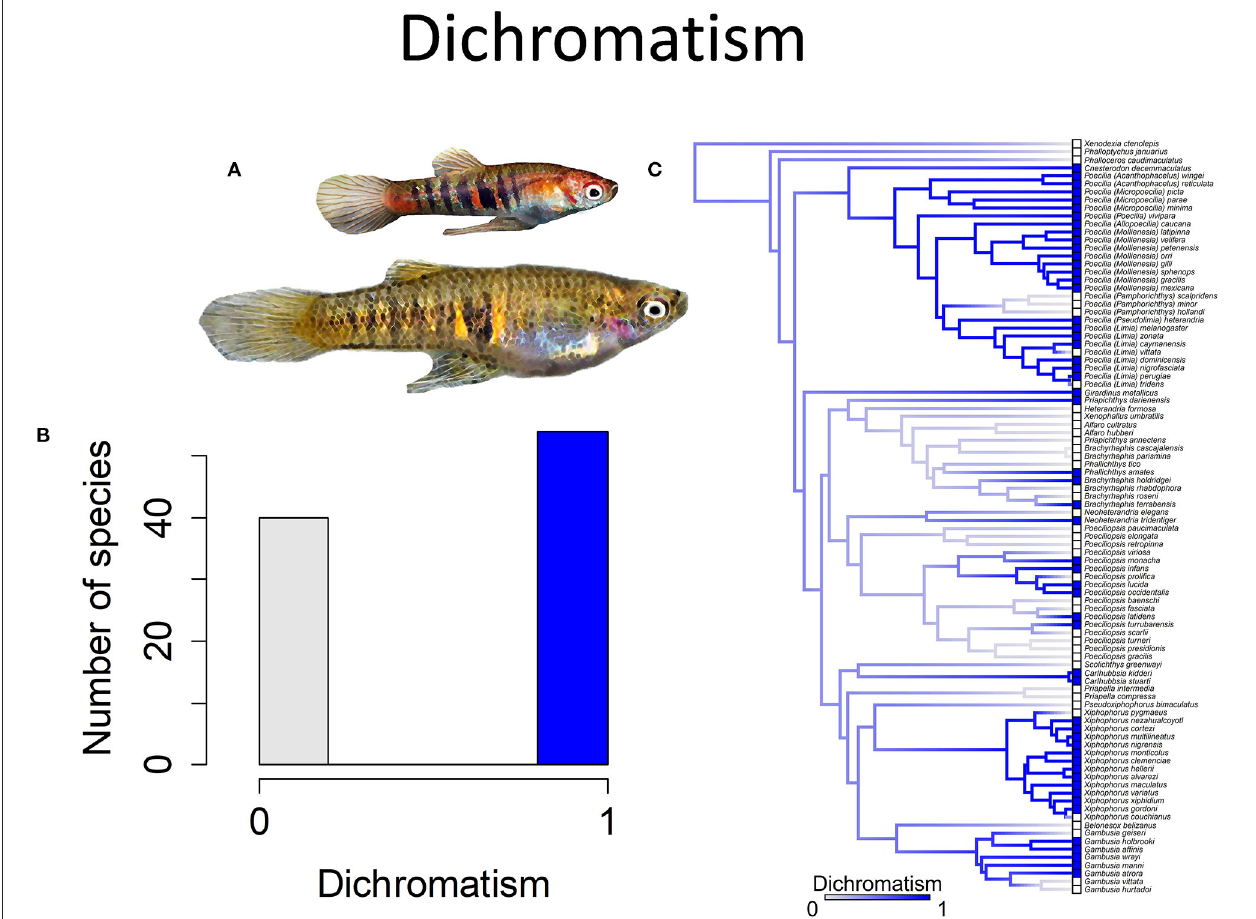
FIGURE 5 | Sexually dichromatic coloration in the family Poeciliidae is when males exhibit brighter and more colorful patterns than females; the alternative is sexually monochromatic coloration in which males and females exhibit similar coloration patterns and intensity. (A) Neoheterandria elegans , exhibits dichromatism with males more brightly colored than females (pictured). (B) Frequency histogram of presence or absence of dichromatism ( n = 94). (C) Ancestral state reconstruction of dichromatism as a binary character was performed using stochastic character mapping in the R package phytools. Branch colors represent posterior densities of edge states based on 1000 stochastic character maps of each reconstruction. The phylogeny tips depict a binary categorization of dichromatism (i.e., absence vs. presence). Figure redrawn after Furness et al. (2019). The most likely ancestral state of the family is the absence of dichromatism (Furness et al.,